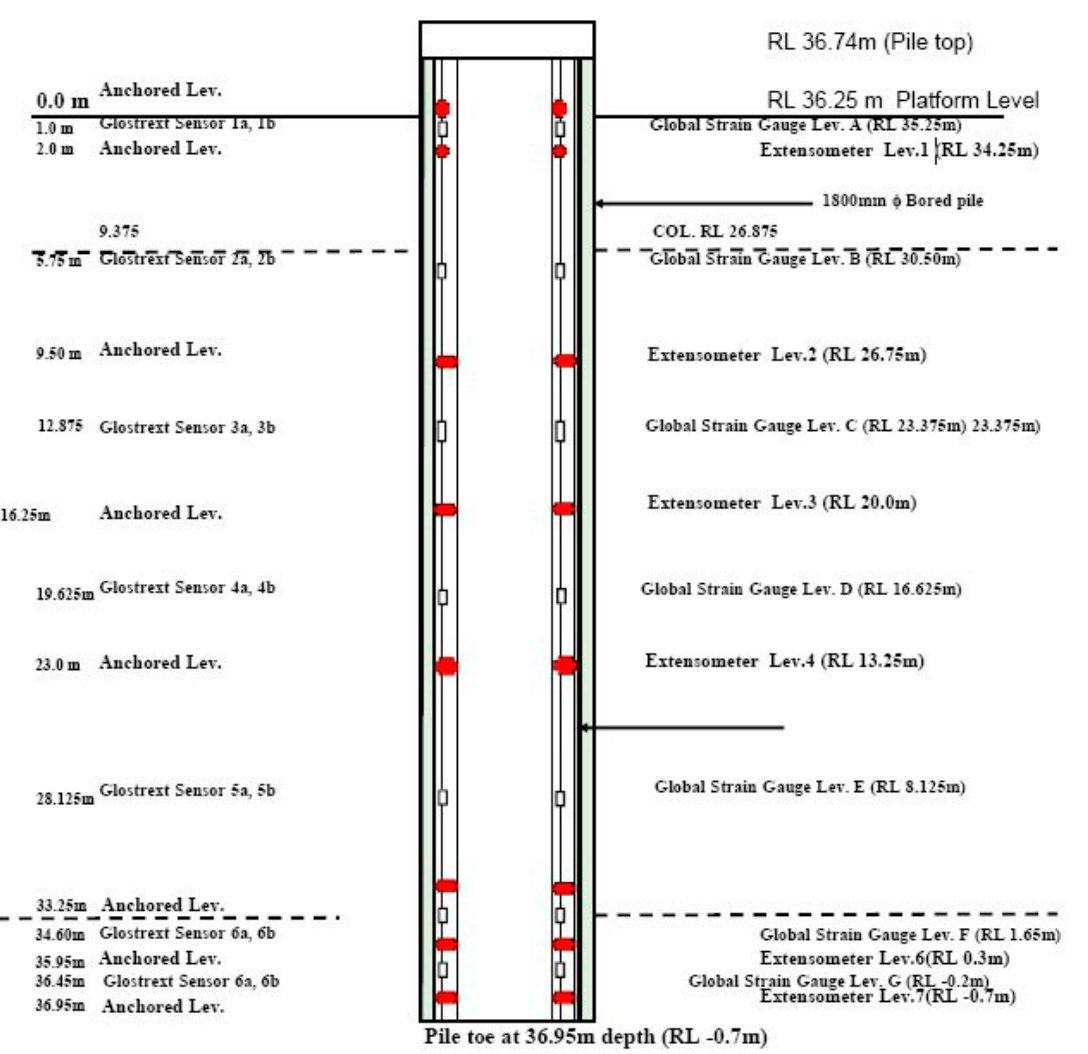
Figure 5. Various instrumental installments at di ff erent global strain extensometer sensors levels in BP# 1.